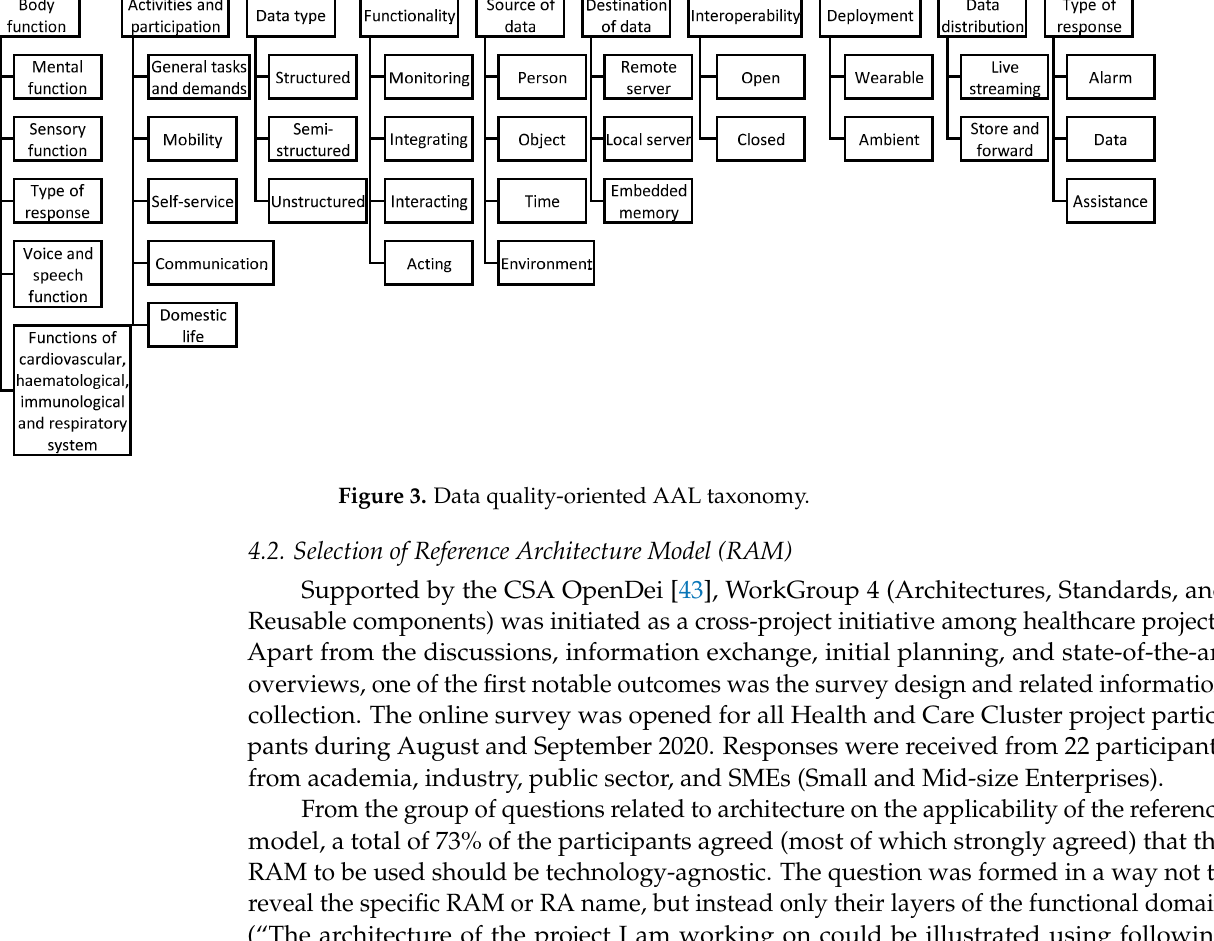
Figure 3. Data quality-oriented AAL taxonomy.